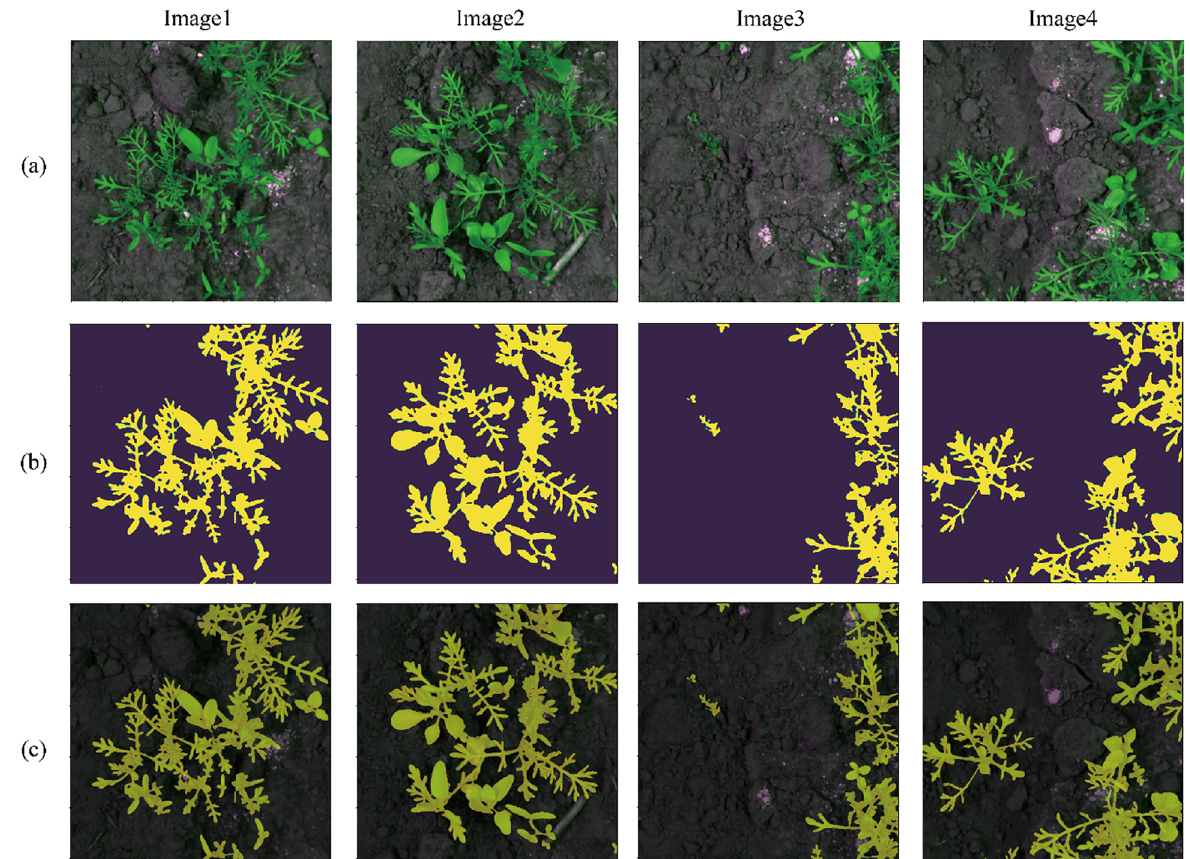
Figure 14. Qualitative results on CWFID dataset. ( a ) input image, ( b ) output of the proposed method, and ( c ) overlay image.